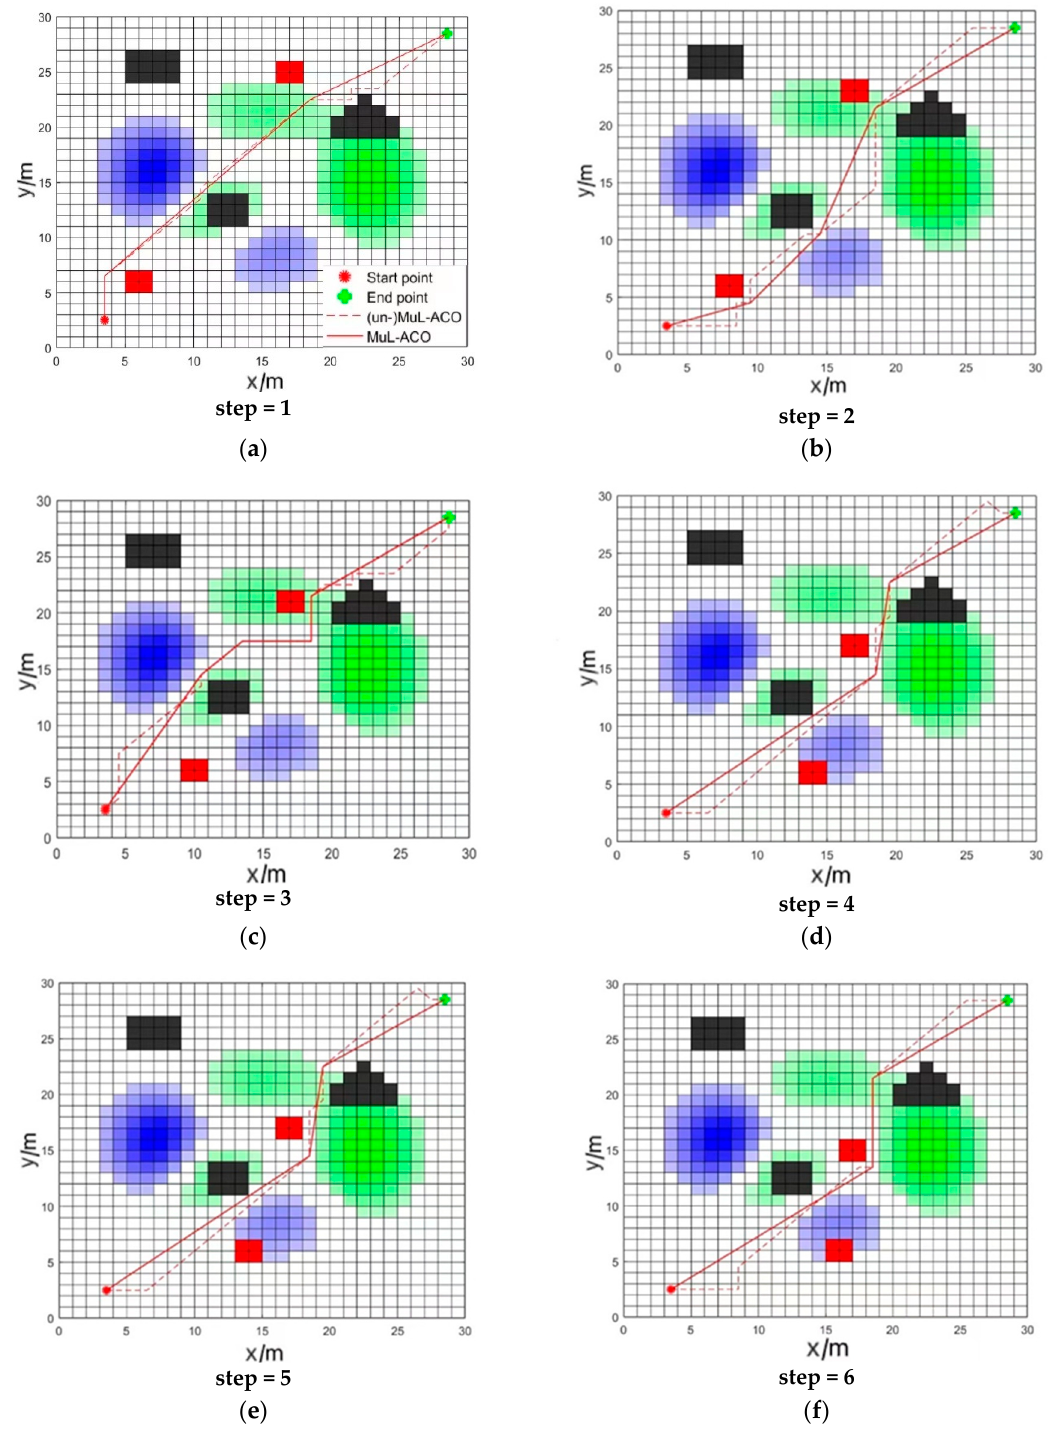
Figure 12. ( a – f ) Results of trajectory generation and optimization at different time steps (step = 1–6) in dynamic environments. Table 6. Simulation results of (un)MH-ACO and MuL-ACO.